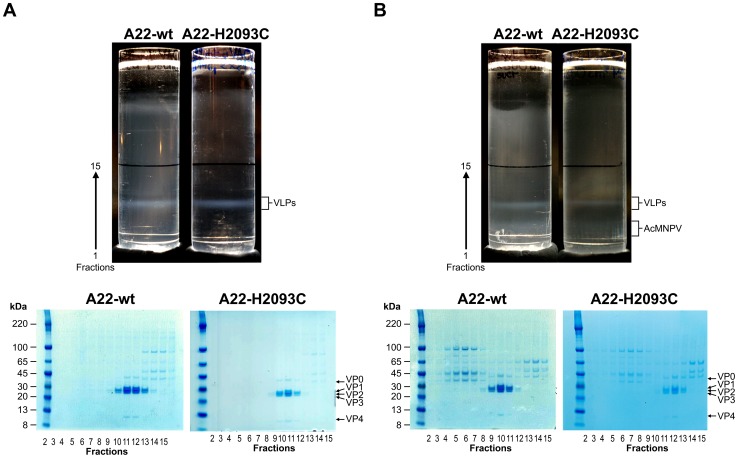
Sucrose gradient purification and SDS PAGE analysis of A22-wt and A22-H2093C recombinant capsids.The extracts from either 2×2125 cm2 roller flasks of HEK293T cells co-infected with recombinant vaccinia viruses, vA22-wt+vTF7-3 or vA22-H2093C+vTF7-3 (a) or from 300 ml culture of Sf9 cells infected with recombinant baculovirus virus, bA22-wt or bA22-H2093C (b) were each loaded onto a 36 ml 15–45% sucrose gradient and centrifuged at 21,000 rpm for 22 h at 12°C (SW32 rotor, Beckman). Bands were visualised by illumination of the gradients from the top with a halogen fibre optic light source (Schott). Fractionation of the lower halves of the gradients was in 13 aliquots of 1 ml (fractions 1–13) and 3 aliquots of 2 ml (fractions 14–16) collected from the bottom: 10 µl each from fractions 2 to 15 were analysed on 4–12% acrylamide Novex NuPAGE gels (Invitrogen).